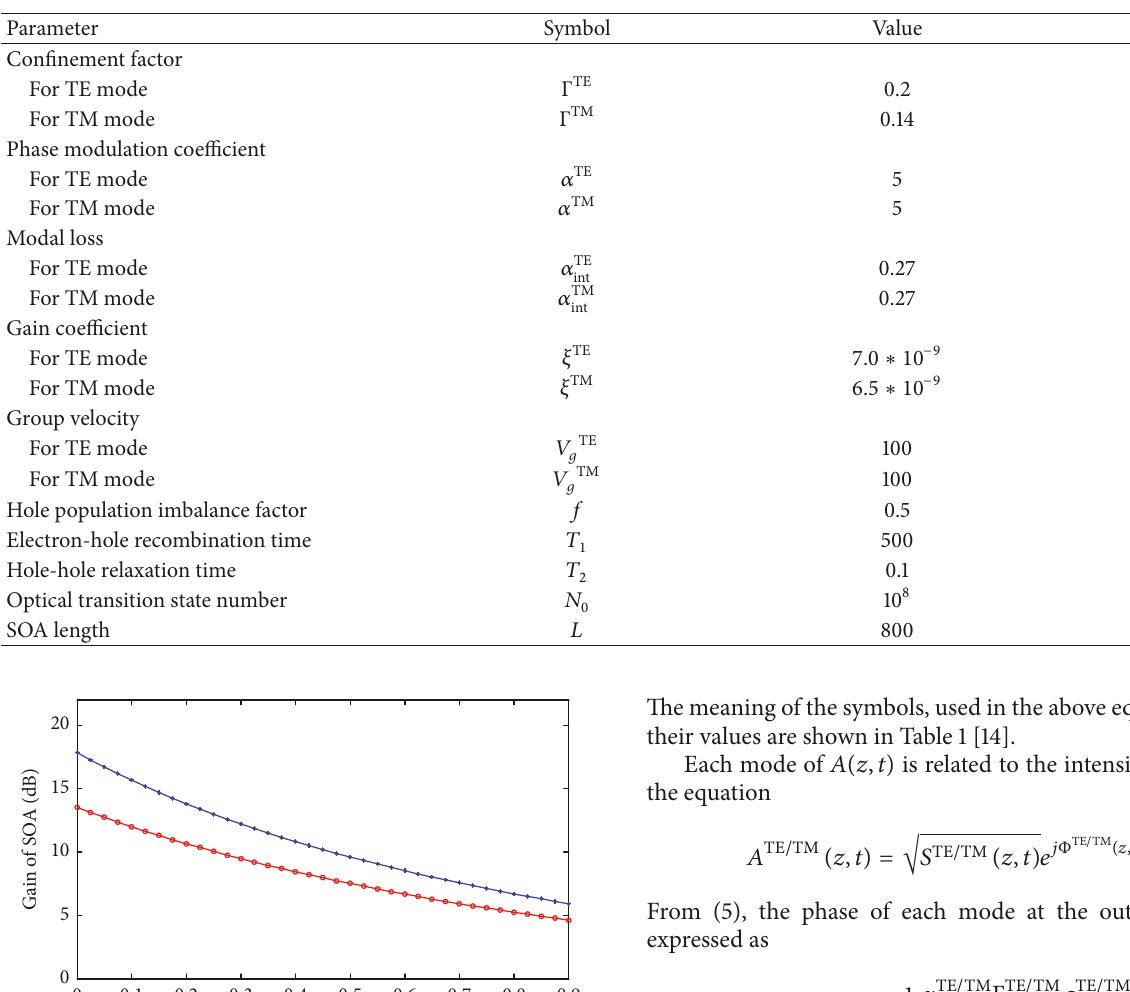
Table 1: Parameters of SOA.